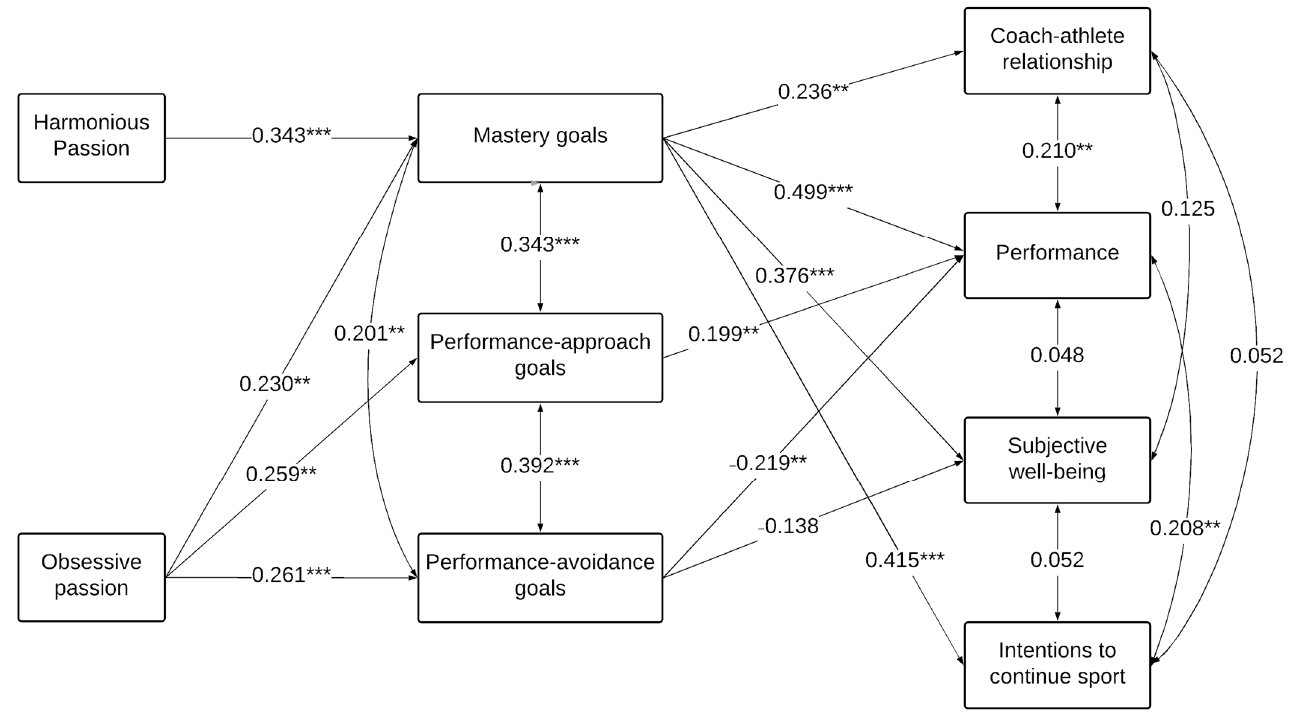
Figure 1. Results of path analyses showing the relations between passion, achievement goals and OFIS components. N = 184; ** p < 0.01, *** p < 0.001. Standardized betas are presented.